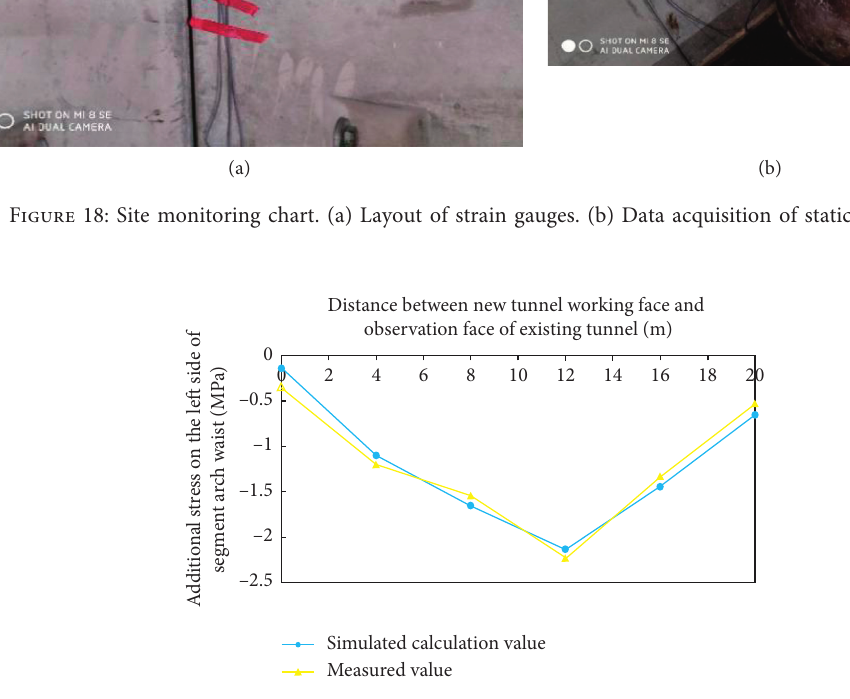
Figure 19: Additional stress of no. 132 ring: monitoring results versus numerical